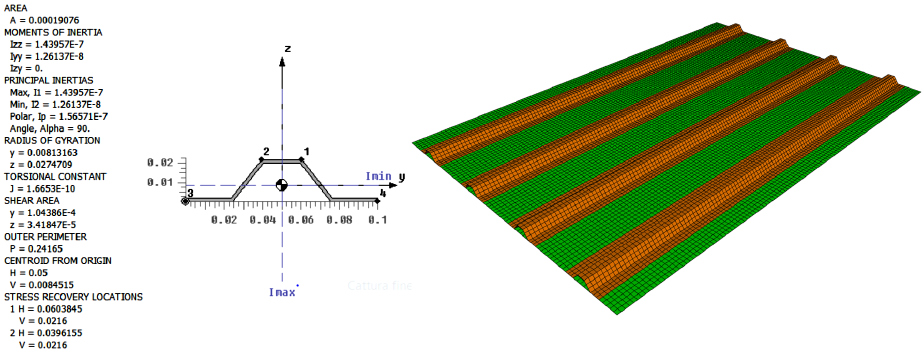
Figure 16. Unconventional flat panel with stiffeners